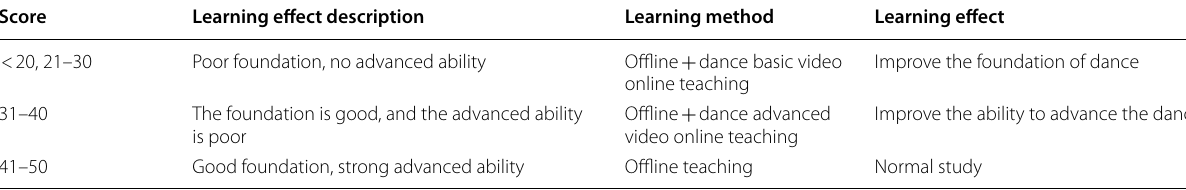
Table 7 Dance teaching methods based on knowledge